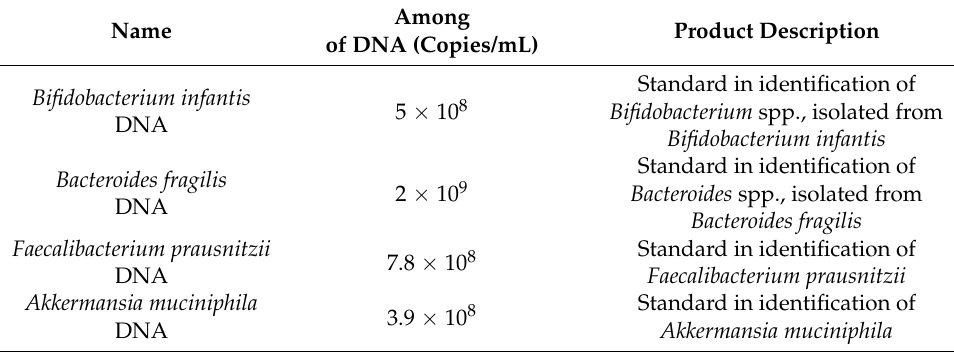
Table 2. Standards applied for the determination of different microorganisms.